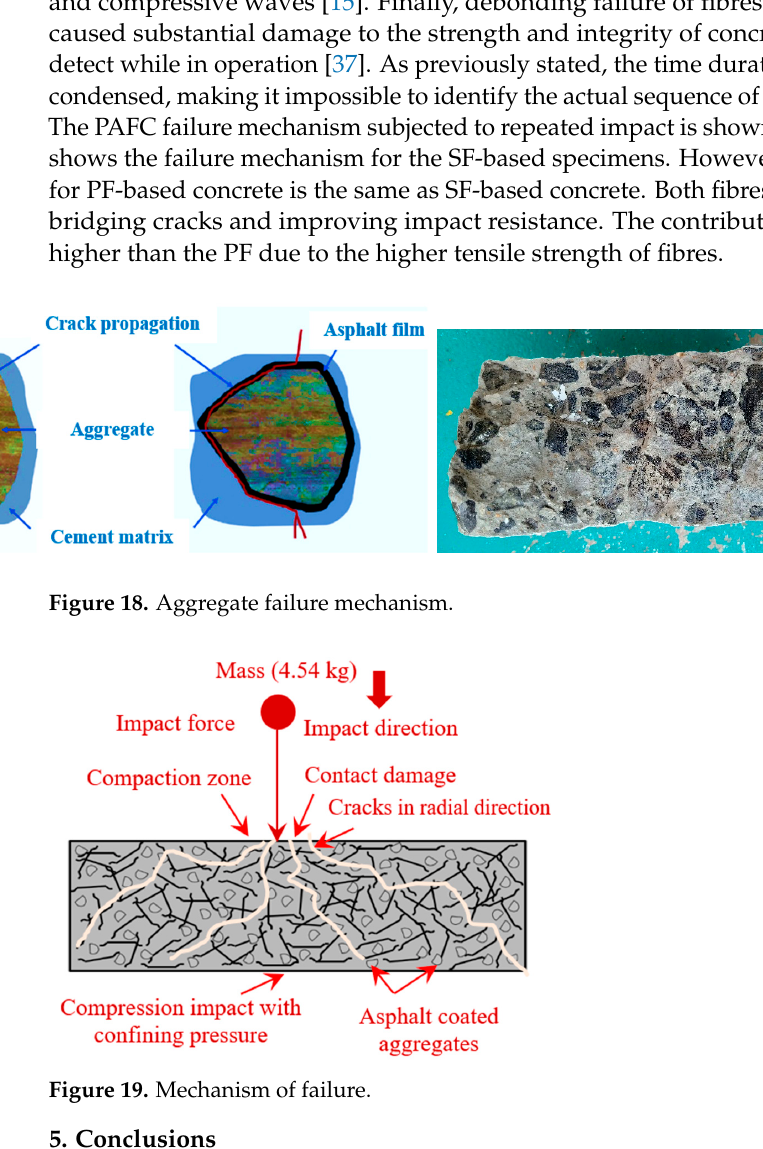
Figure 19. Mechanism of